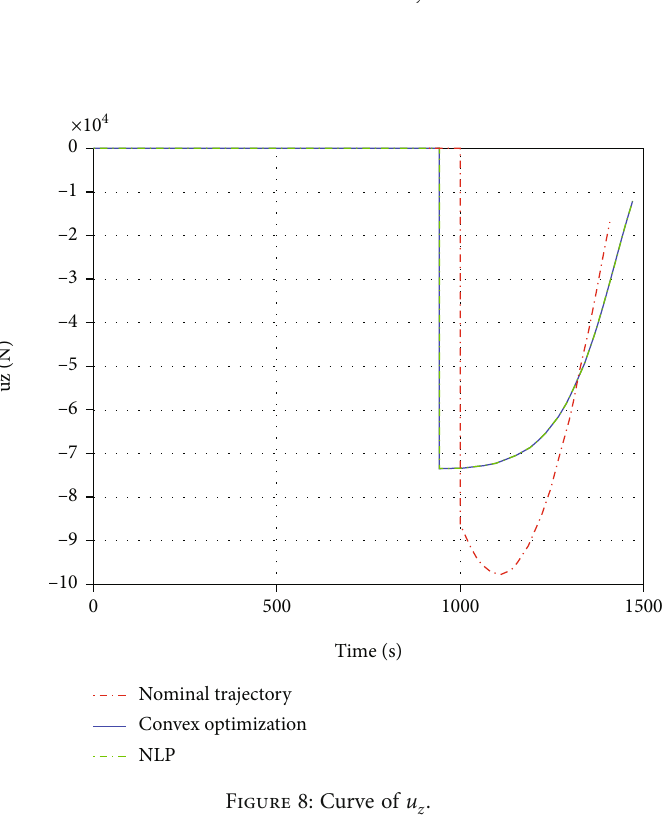
Figure 7: Curve of u